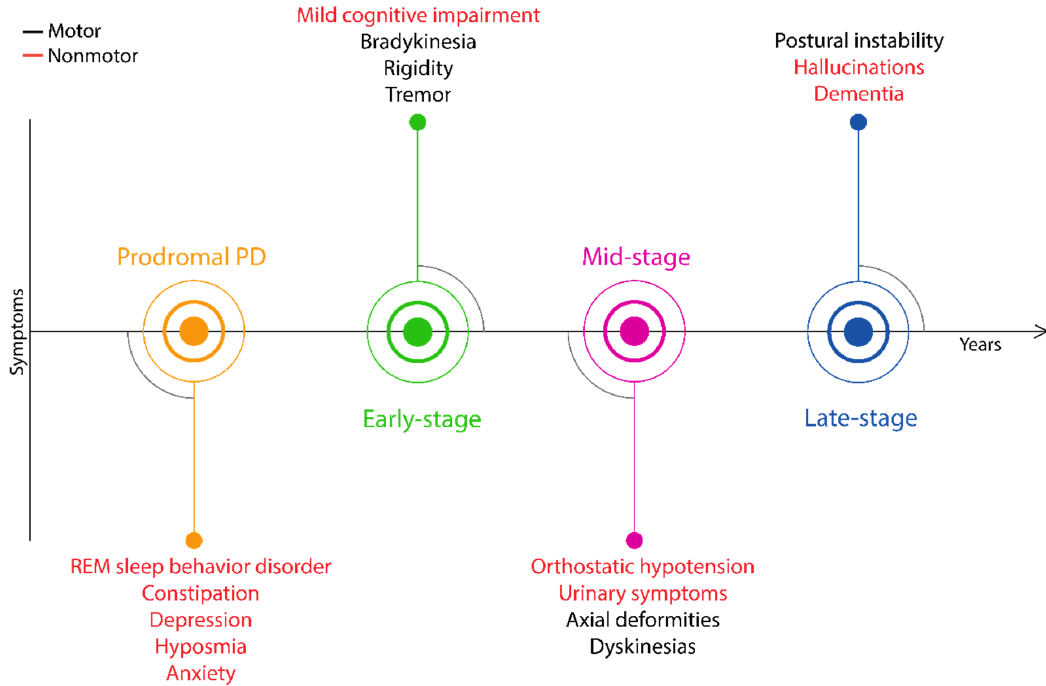
Figure 2. Timeline of clinical signs expressed throughout PD .